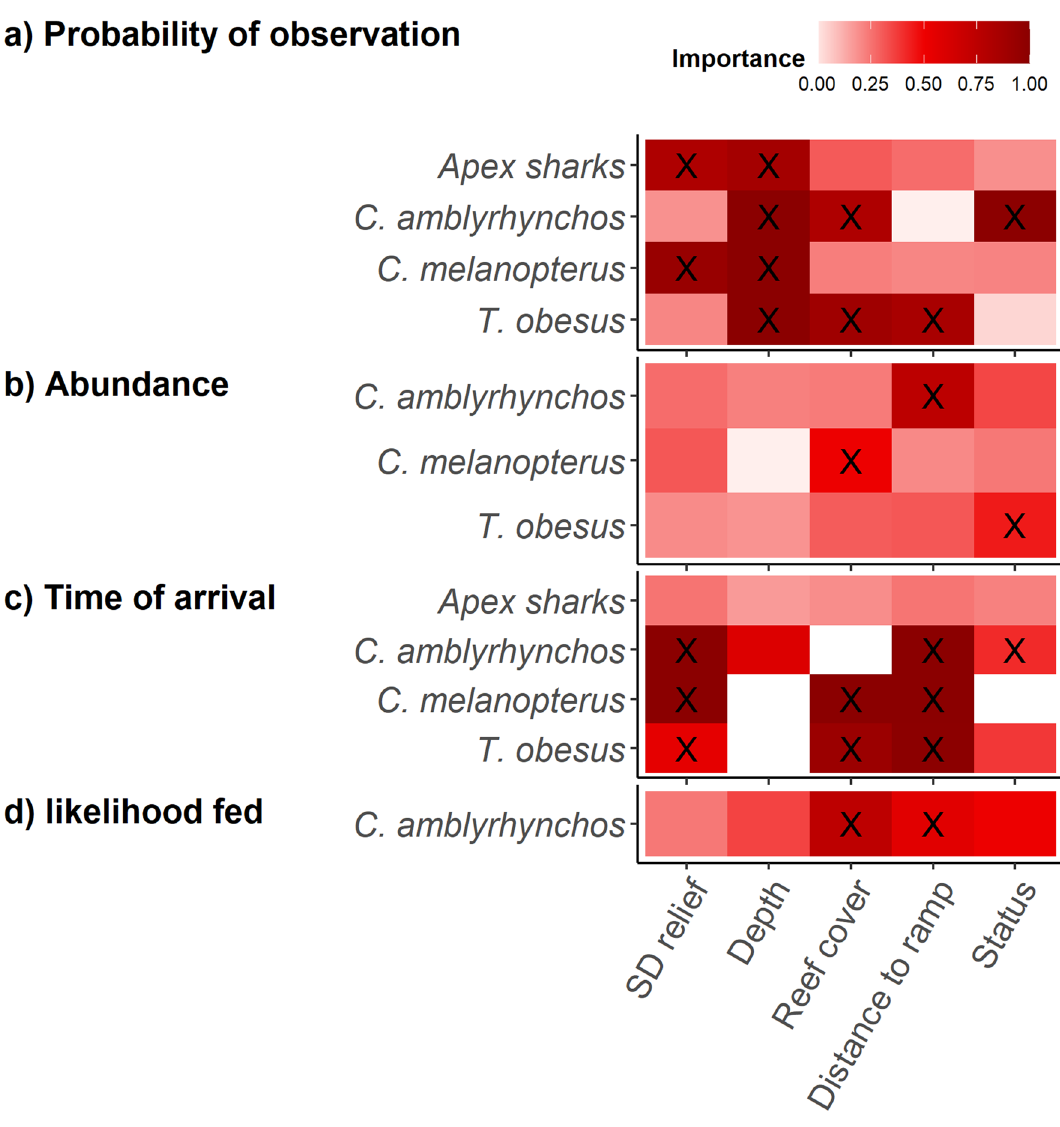
Figure 2. Importance scores based on summed AIC weights from full subsets analysis exploring the influence of five variables on ( a ) probability of occurrence, ( b ) abundance and ( c ) time of arrival on BRUVs, and (d) likelihood fedfor each shark taxa. The ‘X’ symbols indicate variables that were included in the most parsimonious models (See Table 1). Figure was generated using R 14 using ggplot2 15